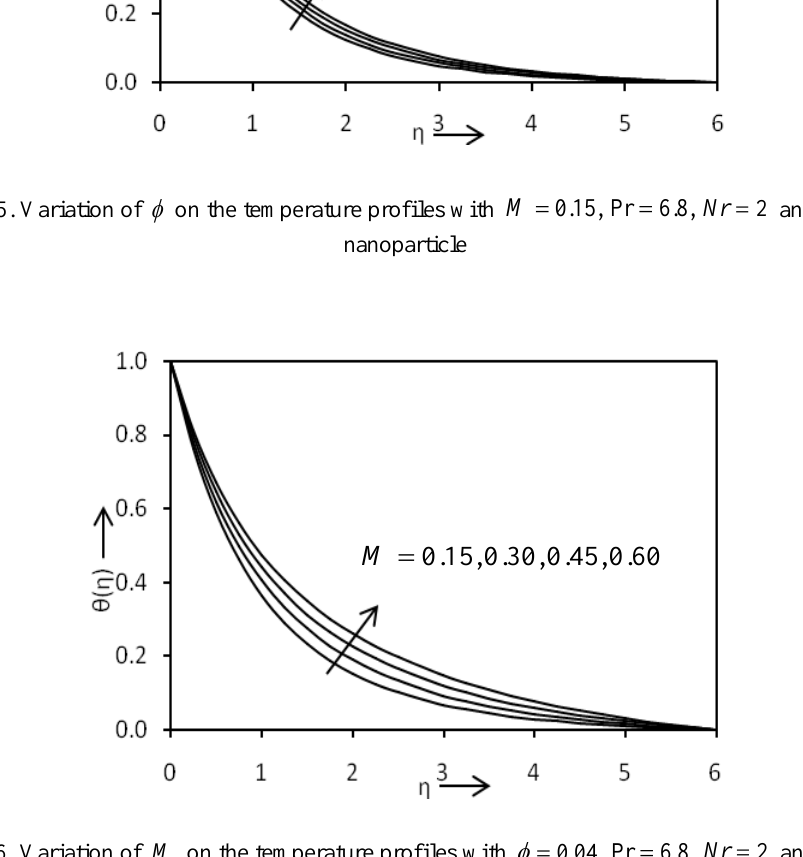
Figure 6. Variation of M on the temperature profiles